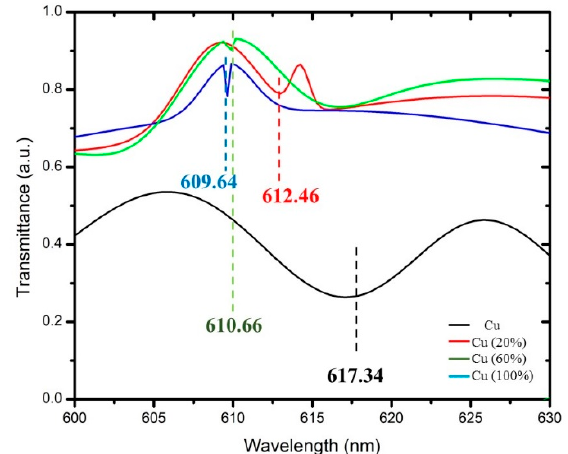
Figure 7. SPR sensor’s transmittance spectra versus the wavelength for Cu shifts at different alcohol refractive indexes as (black line) Cu at a 617.34 nm (red line) wavelength of Cu as 612.46 nm sensed at 20% of alcohol (green line); 610.66 nm of Cu sensed at 40% of alcohol; and (blue line) of Cu sensed using 60% of the alcohol concentration at 609.64 nm.